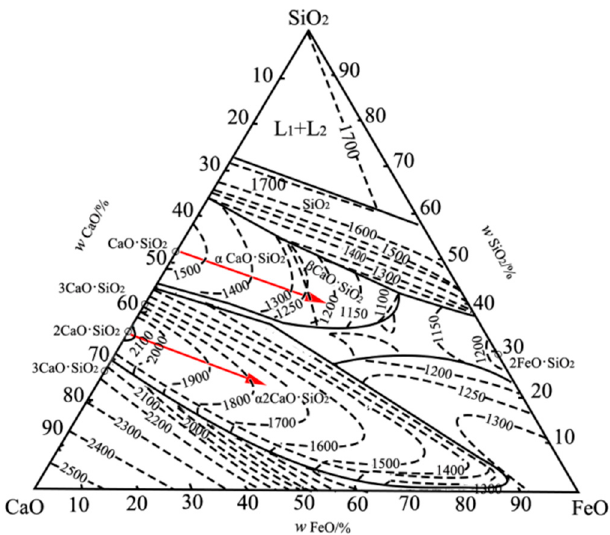
Figure 11. Phase diagram of the SiO 2 -CaO-FeO slag system.